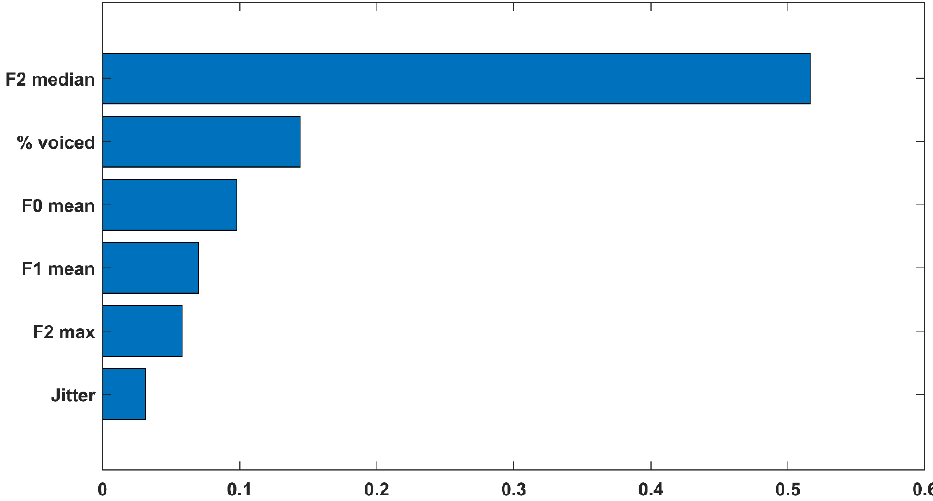
Figure 3. Acoustical parameters sorted in descending order on the basis of the ratio between their weight and the total weight for the R index.